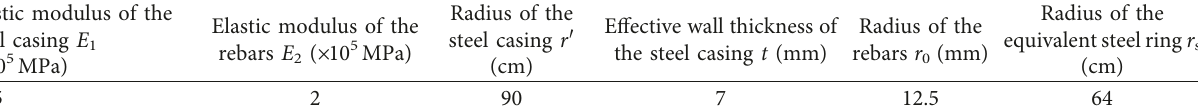
Table 8: Parameters used in the calculation of optimal reinforcement for the FY3#-0 CCFSTP. Elastic modulus of